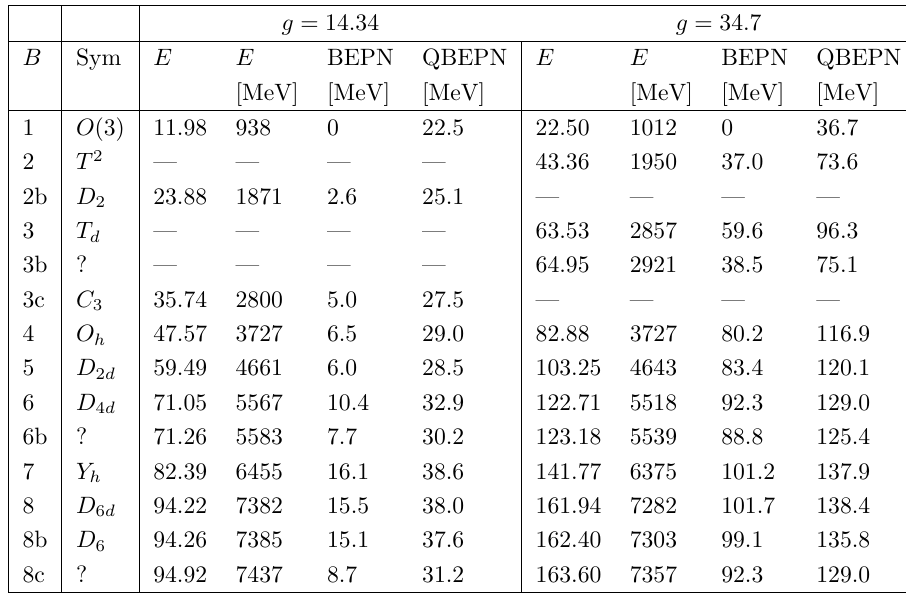
Table 2 . Energies of the numerical solutions for two values of the coupling, g = 14 : 34 and g = 34 : 7. The column ’Sym’ shows the symmetry group of the Skyrmion solution, if known. The columns for each value of the coupling represent the energy in Skyrme units, the energy in MeV, the binding energy per nucleon (BEPN) in MeV and the quantum binding energy per nucleon (QBEPN) in MeV. The mass ratio is m = 0 :